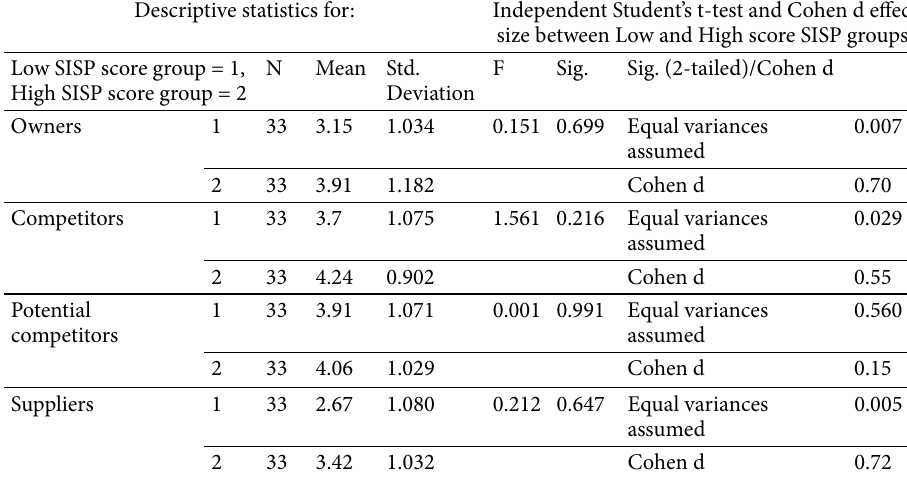
Table 2. Basic descriptive statistics, Independent Student’s t-test and Cohen d effect size between Low and High SISP score groups for the influences of individual environmental stakeholders on the quality of SISP Descriptive statistics